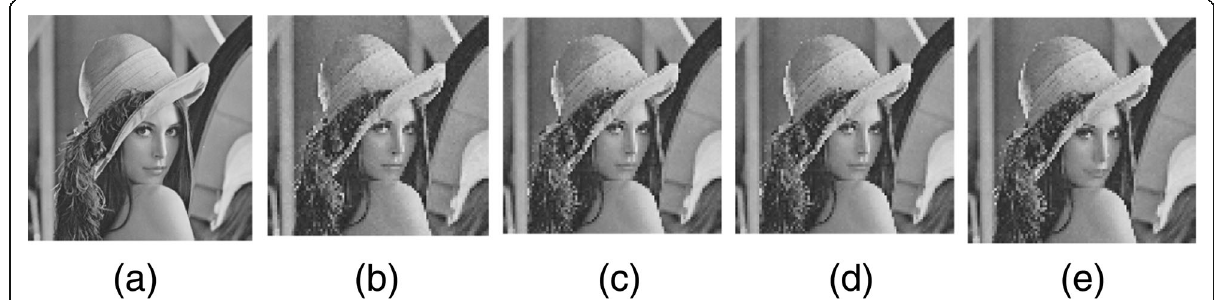
Fig. 17 Comparison results of Lena watermarked image of four schemes [1, 7, 24, 48]. a Original image. b PSNR = 37.15 dB [1]. c PSNR = 44.15 dB [7]. d PSNR = 44.27 dB [24]. e PSNR = 44.16